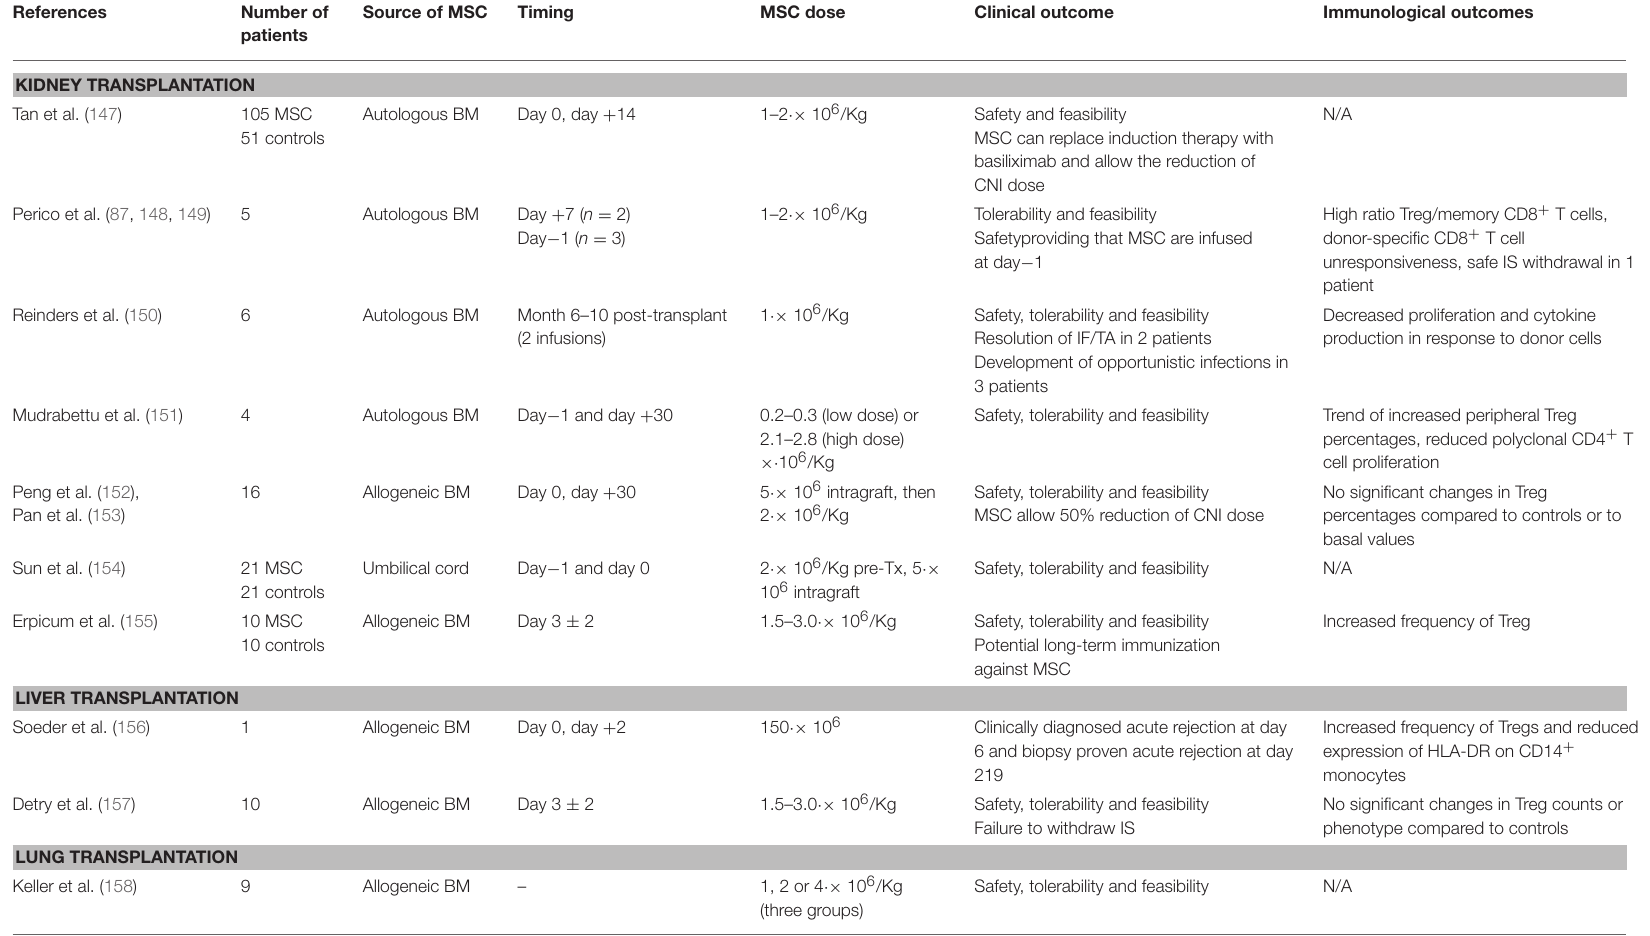
TABLE 3 | Summary of clinical trials assessing MSC infusion in the setting of renal, liver and pulmonary